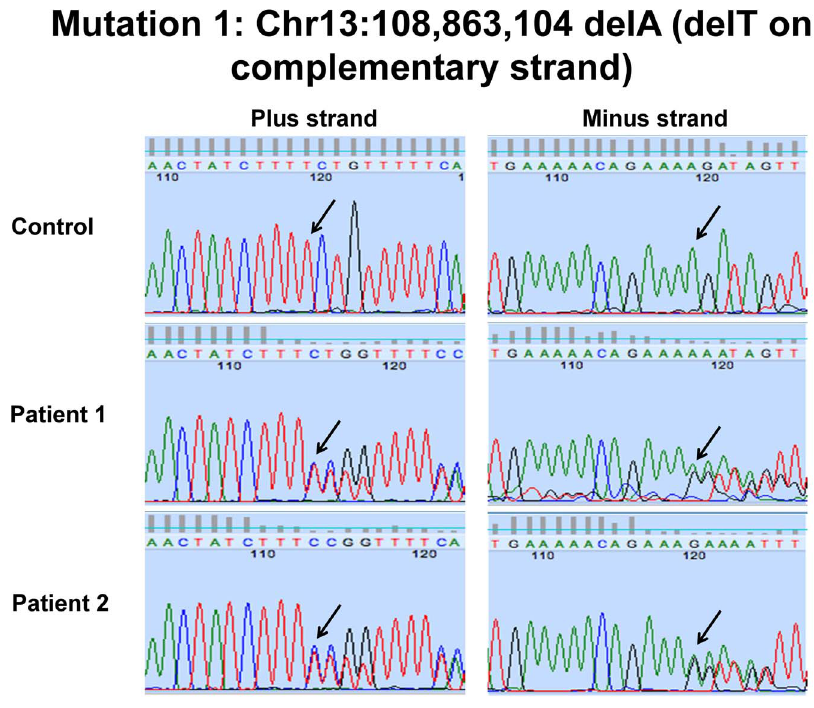
Figure 10. Sanger sequencing of LIG4 c.613delT variant in Patients 1 and 2.